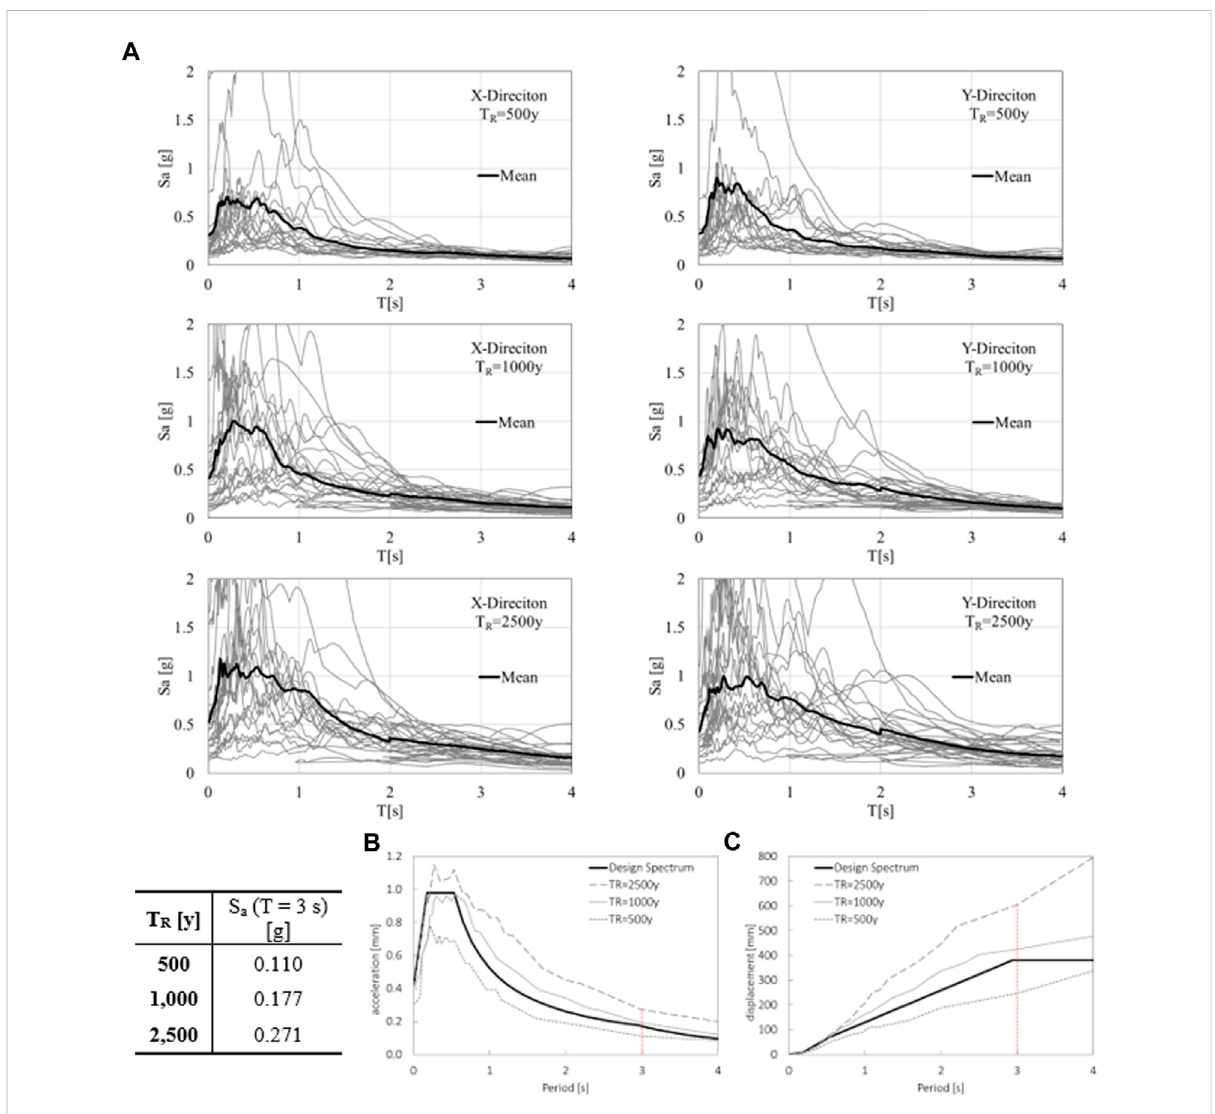
FIGURE 8 (A) Acceleration spectra for the 20 chosen records in X and Y directions for the selected return Periods T R . (B, C) Mean spectral accelerations S a ( T (cid:1) 3 s ) for the selected return periods T R , and design and mean spectra of the seismic inputs acceleration (B) and displacement (C)